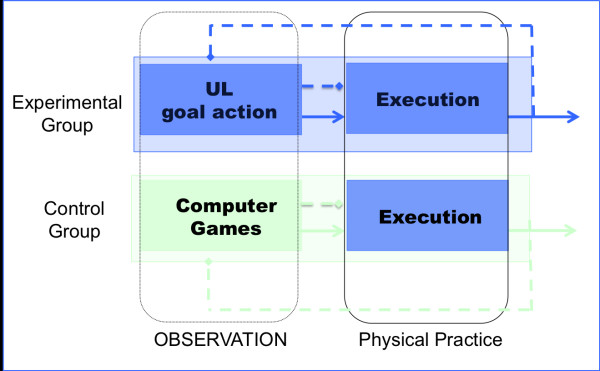
Layout of Study Treatment.